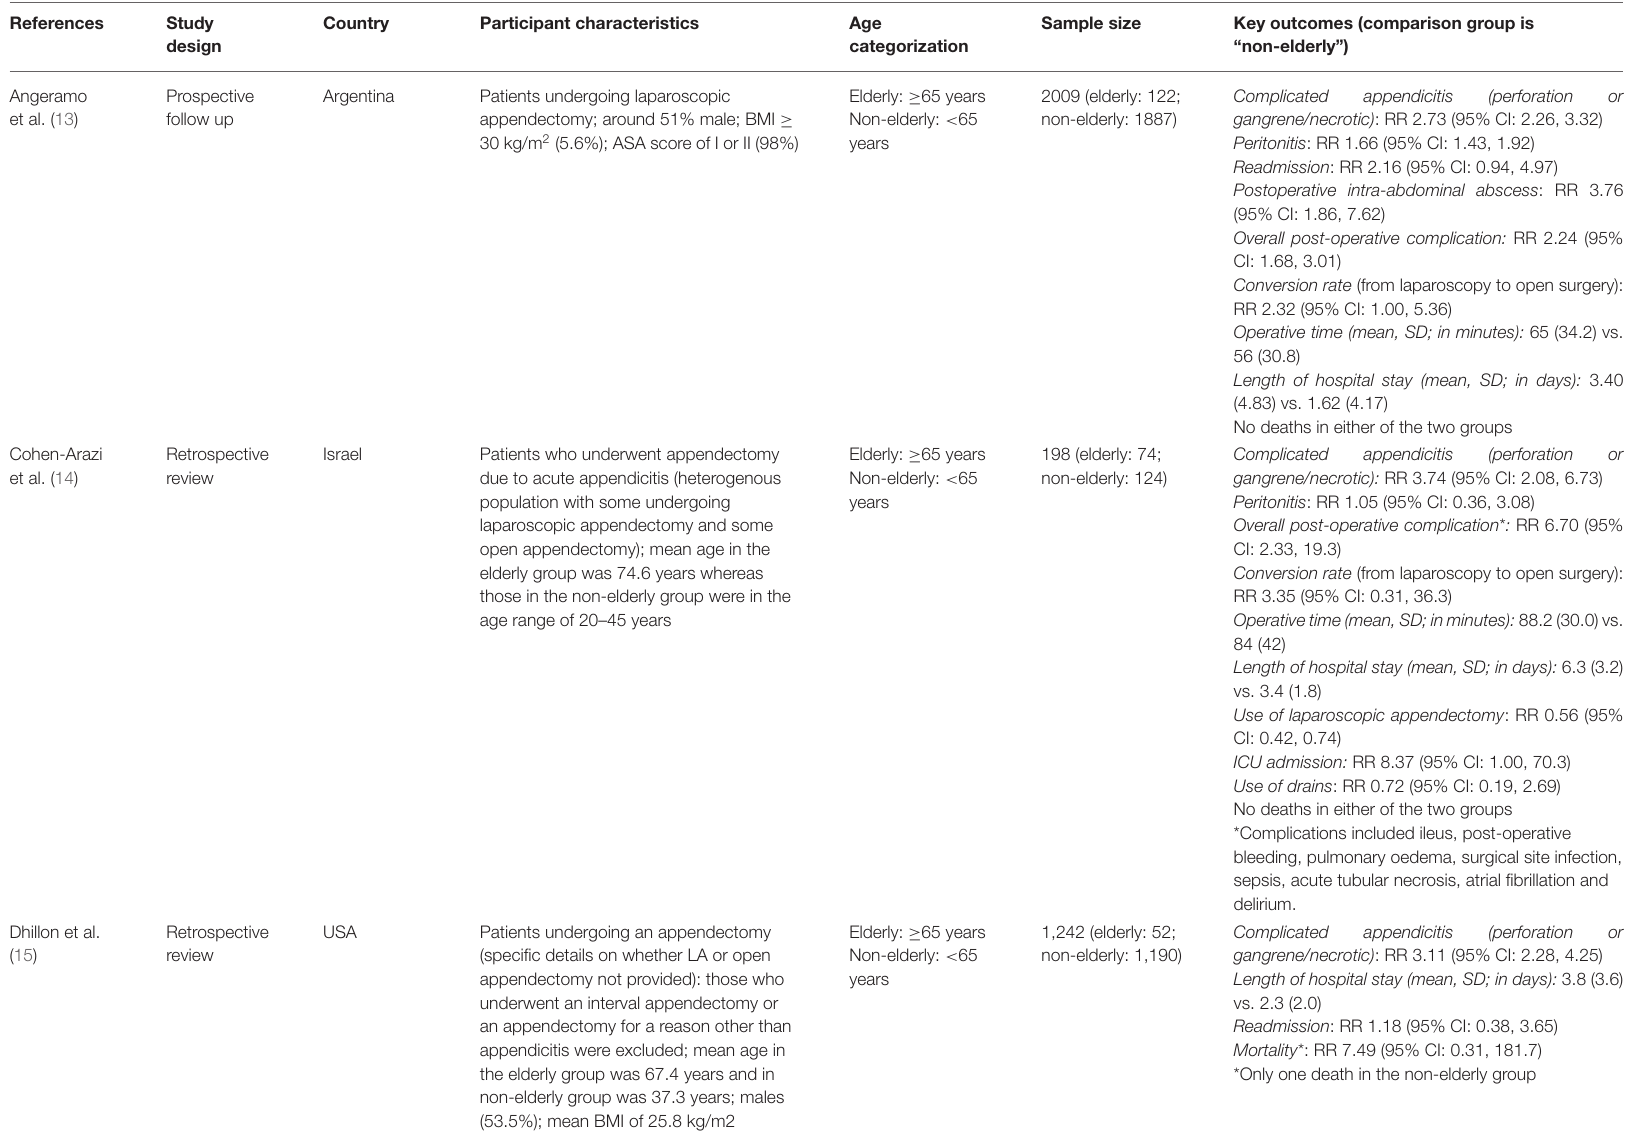
TABLE 1 | Characteristics of the studies included in the meta-analysis.